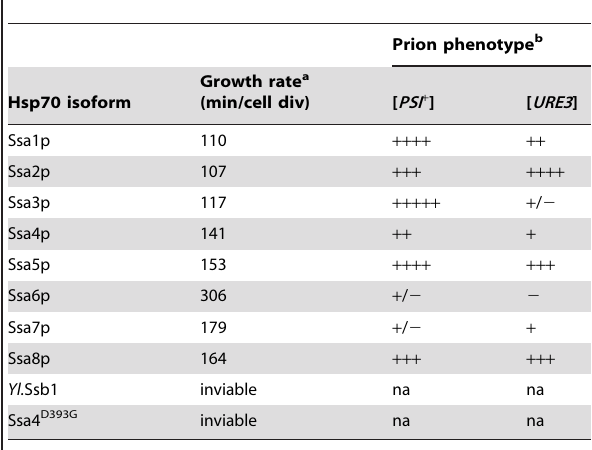
Table 2. Growth rates and prion phenotypes of strains expressing individual Ssa